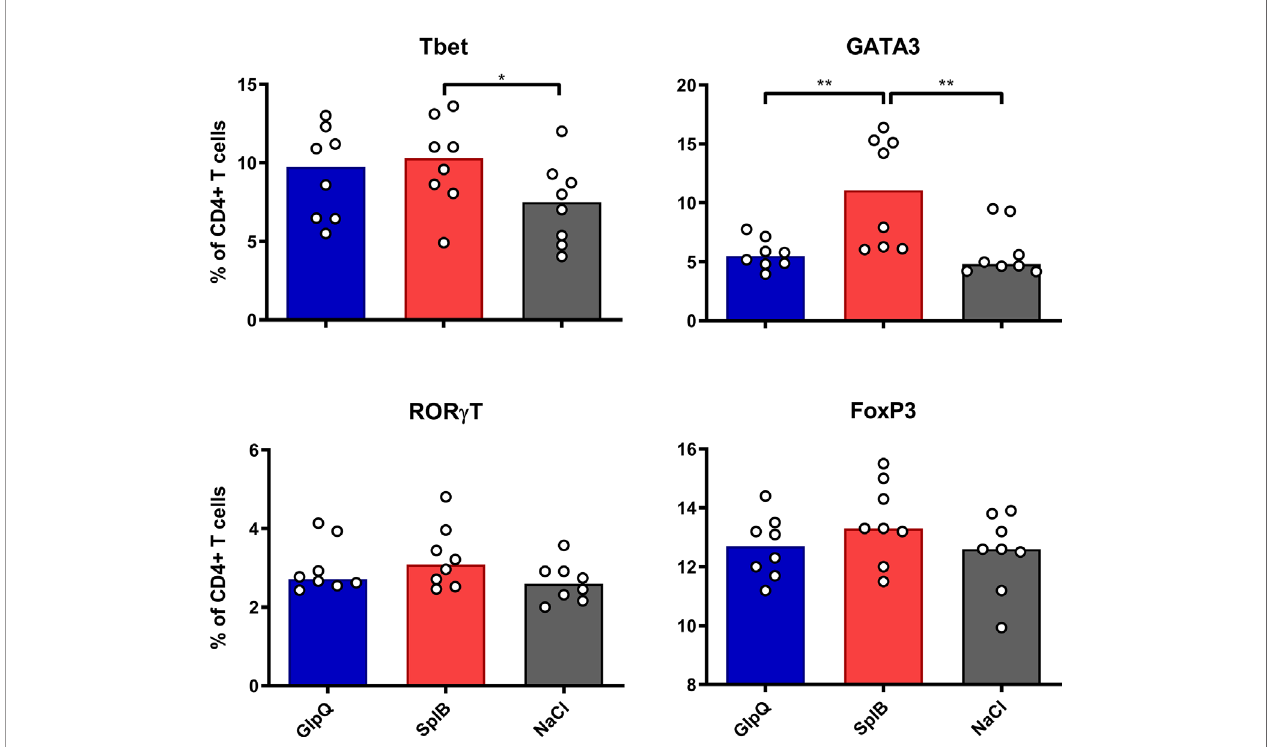
FIGURE 1 | SplB induced Th2 cells. C57BL/6N mice were primed and boosted with non-adjuvanted antigen. Seven days after the boost, splenocytes were isolated and stained for Th1- (Tbet), Th2- (GATA3), Th17- (ROR g T) and Treg- (FoxP3) speci fi c transcription factors. Data are presented as median. n = 8 animals per group. *p < 0.05; **p < 0.01. Group comparisons that are de fi ned in the “ Statistical analysis ” section but not shown here are not signi fi